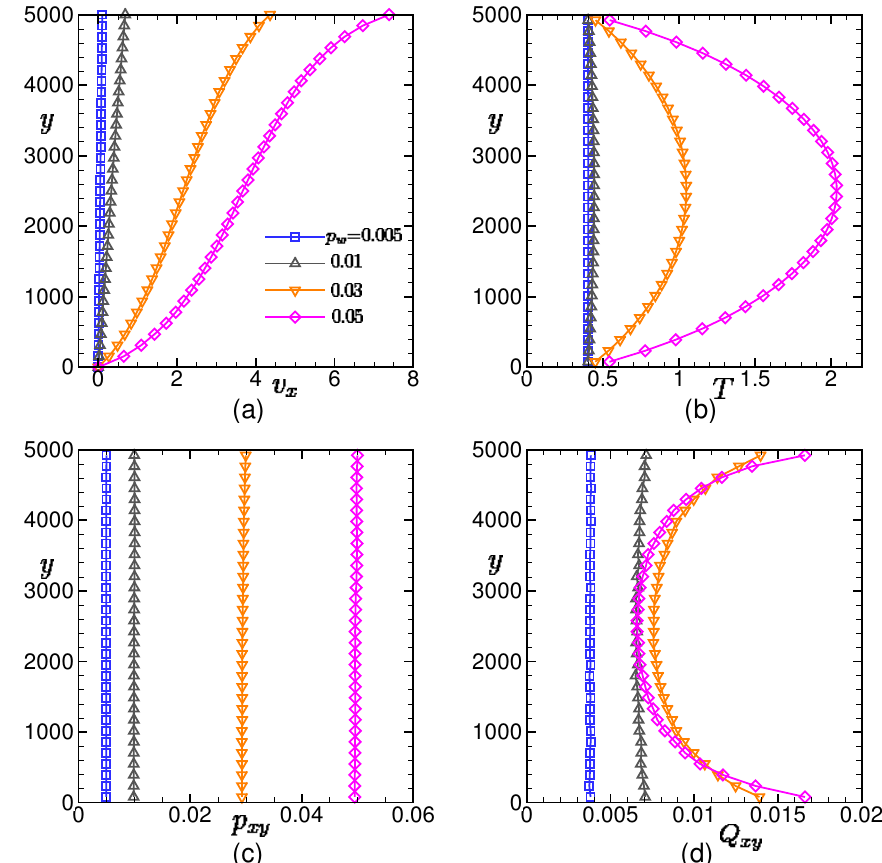
Figure 4. Spatial distributions of the ( a ) velocity, ( b ) temperature, ( c ) shear stress, and ( d ) bond orientation in the stationary state. The results for the different drive forces p w = 0.005, 0.01, 0.03, and 0.05 are shown. On the vertical axis, y = 5000 corresponds to the wall that is in motion, while y = 0 corresponds to the wall that is at rest. In each figure, the local quantities are time-averaged in the stationary